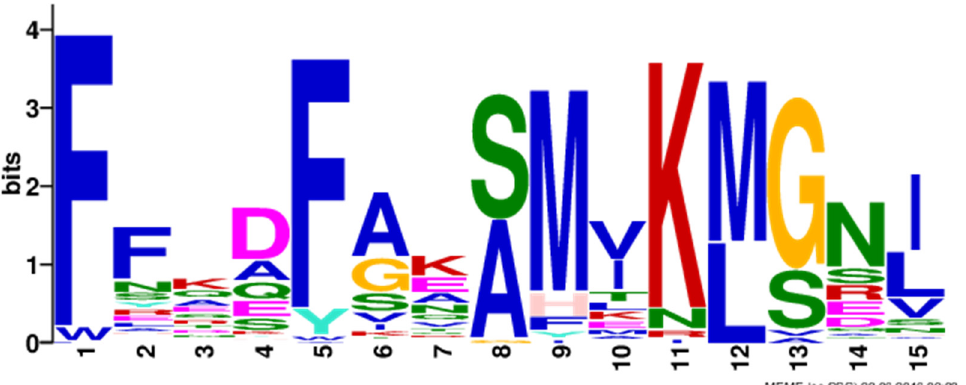
Figure 2. The most motif structure of PbPRX gene family. Table 2. Major MEME motif sequences in pear PRX